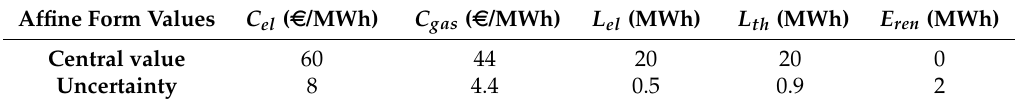
Table 2. Central value and partial deviations of each uncertain